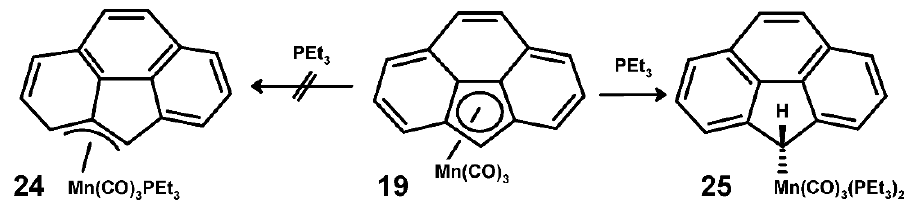
Figure 5. Molecular structure of ( η 6 -octahydro-cpp)Cr(CO) 3 , 23 .